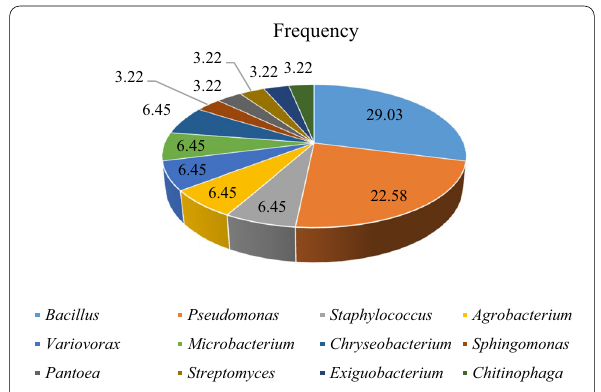
Fig. 3 Frequency of the identified genera of endophytic bacteria from kiwifruit